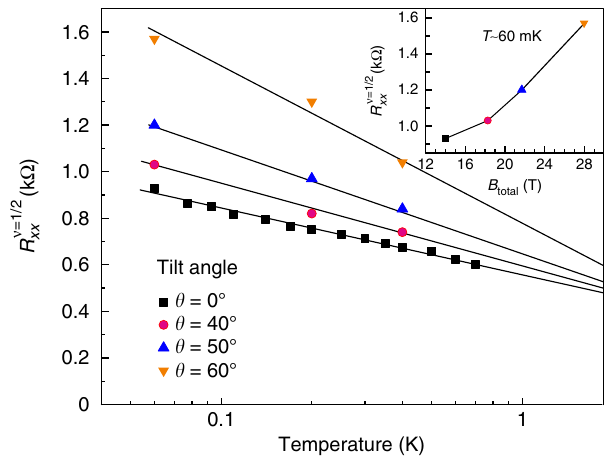
Fig. 4 R xx temperature dependence at ν = 1/2. The resistance decreases with increasing temperature indicating a residual interaction between the composite fermions at zero tilt angle. The slope becomes more pronounced at higher tilt angles, i.e., a stronger in-plane fi eld, and points towards a more robust Wigner solid